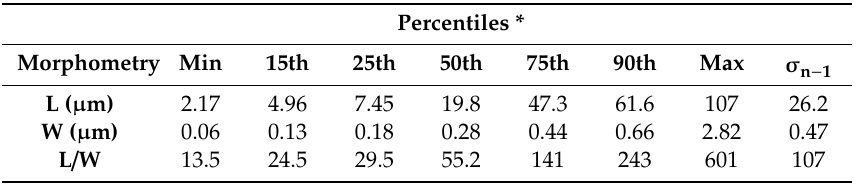
Table 1. Morphometry of the coated and non-coated fibres recovered from the studied lung tissue. * Percentile indicates the value below which a given percentage of values in a data set fall. L (length); W (width); Min (minimum); Max (maximum); σ n − 1 (standard